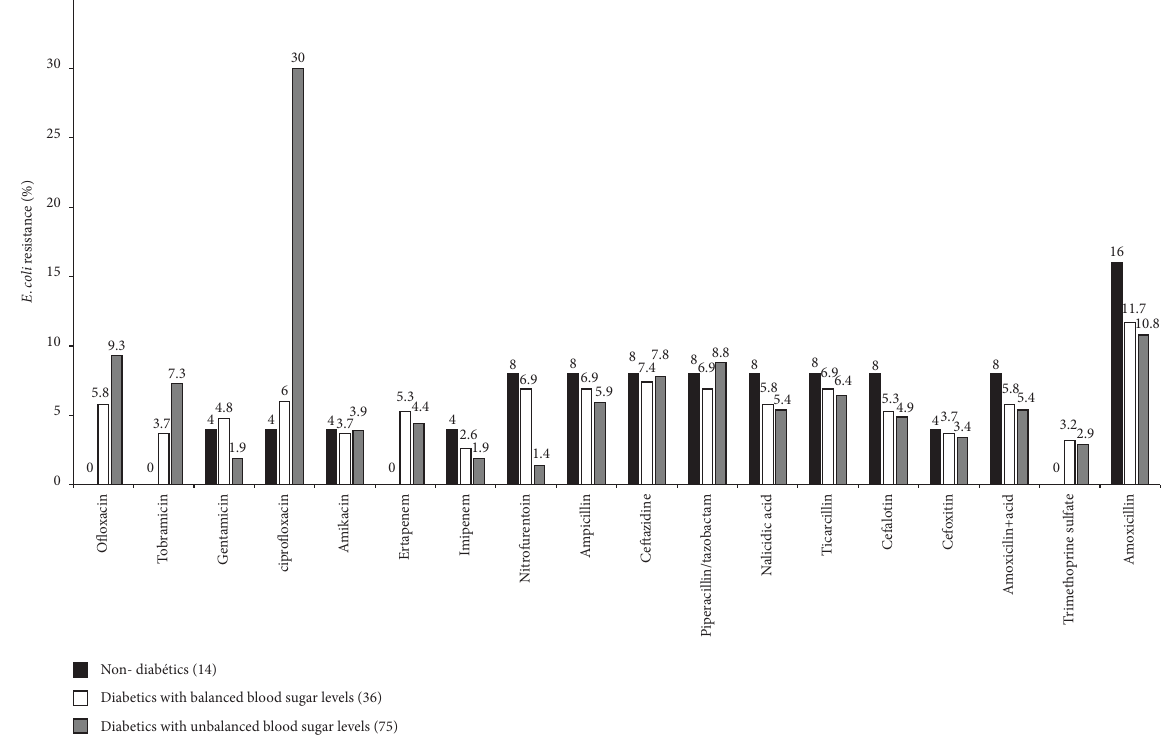
Figure 2: Distribution of E. coli antibiotic resistance profle as a function of diabetic status.